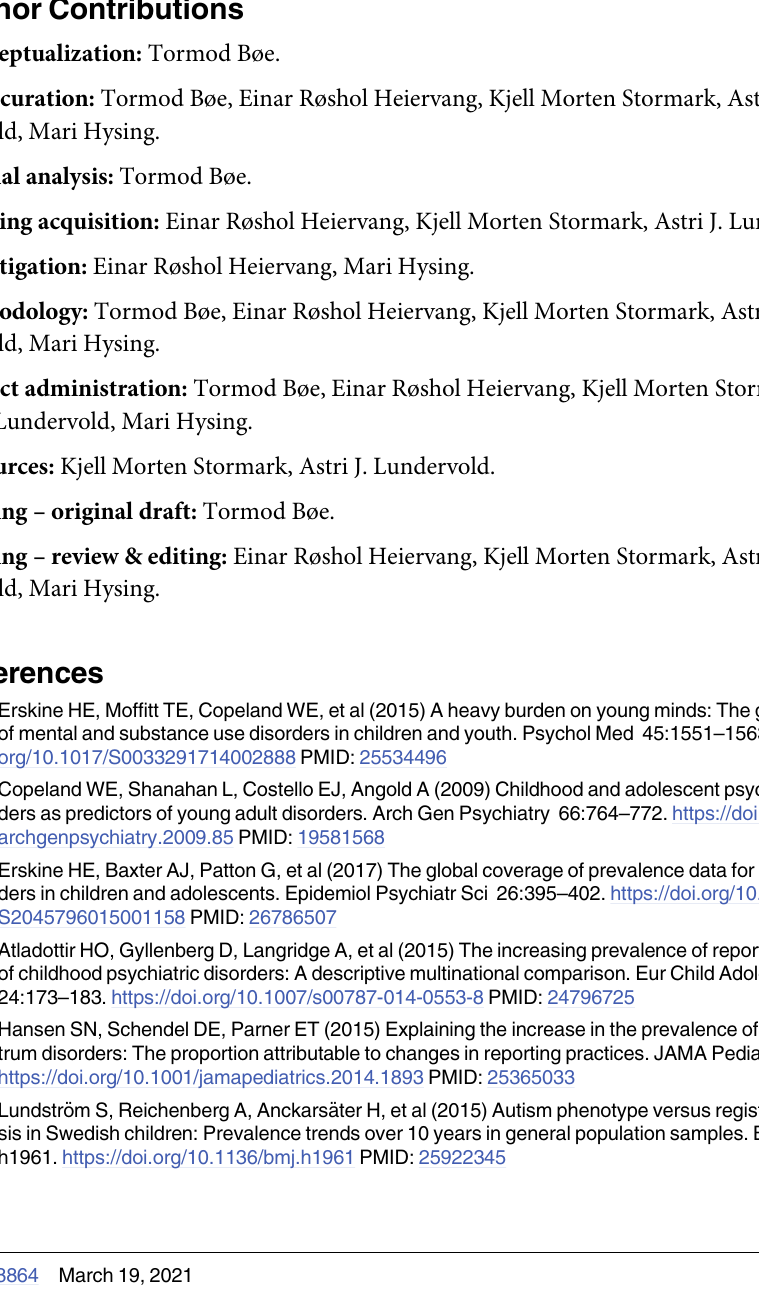
S1 Table. Prevalence of DSM-IV disorders among 10-14-year-old participants in the Ber- gen Child Study. S2 Table. Prevalence of DSM-IV disorders among 10-14-year-old participants in the Ber- gen Child Study, by